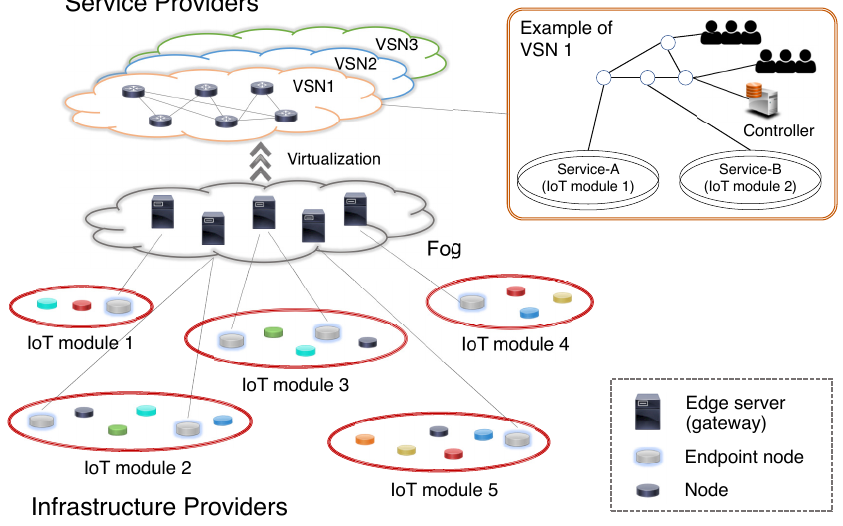
Figure 1. Architecture for virtualized wireless sensor networks